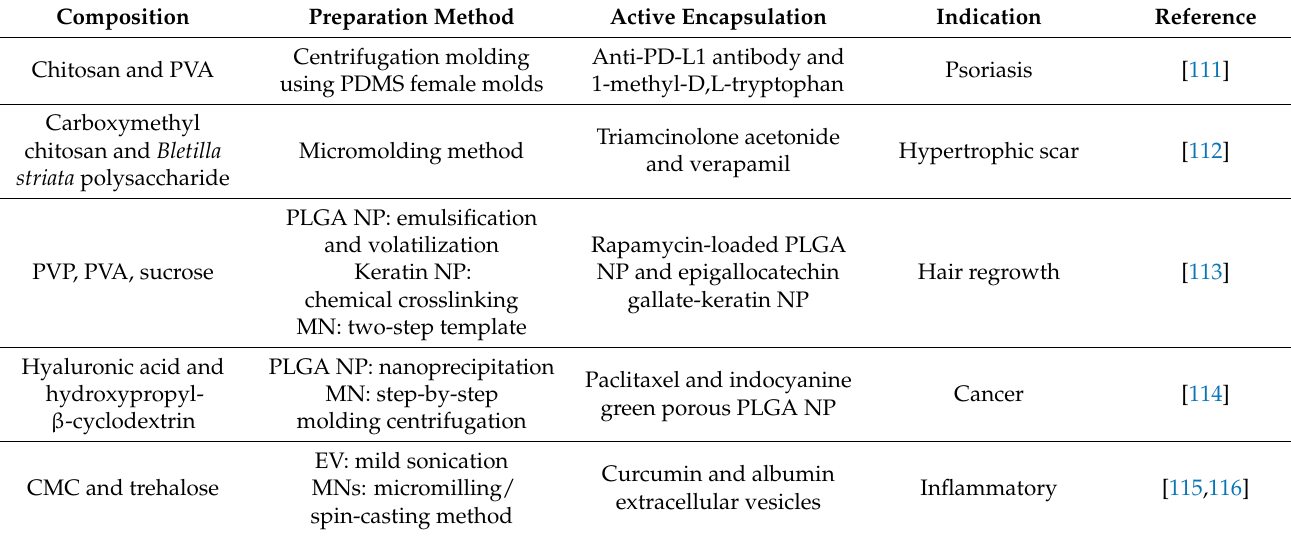
Table 7. Examples of microneedles formulated with combined drugs or for the delivery of nanoparti- cles and the diseases that can benefit from co-encapsulated